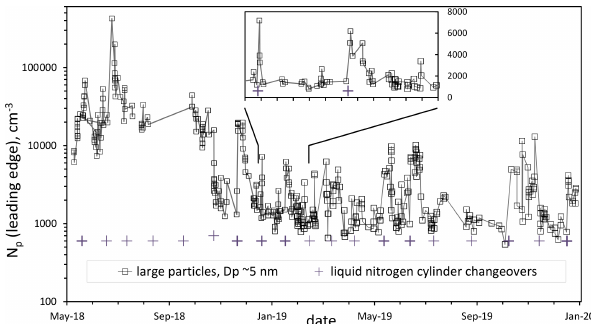
Figure 1. Particle number density in the leading edge of the DEG system distribution over time for standard conditions ( Q 4 = 4 . 2sccm, 52%RH, 296K). Leading edge refers to all particles de- scribed by a log-normal distribution of the largest particles (roughly 5nm mode diameter for these conditions). The approximately monthly liquid nitrogen cylinder changeovers are indicated by the + symbols; bold indicates there is an associated spike in N p . The inset shows a 60d period of data on a linear